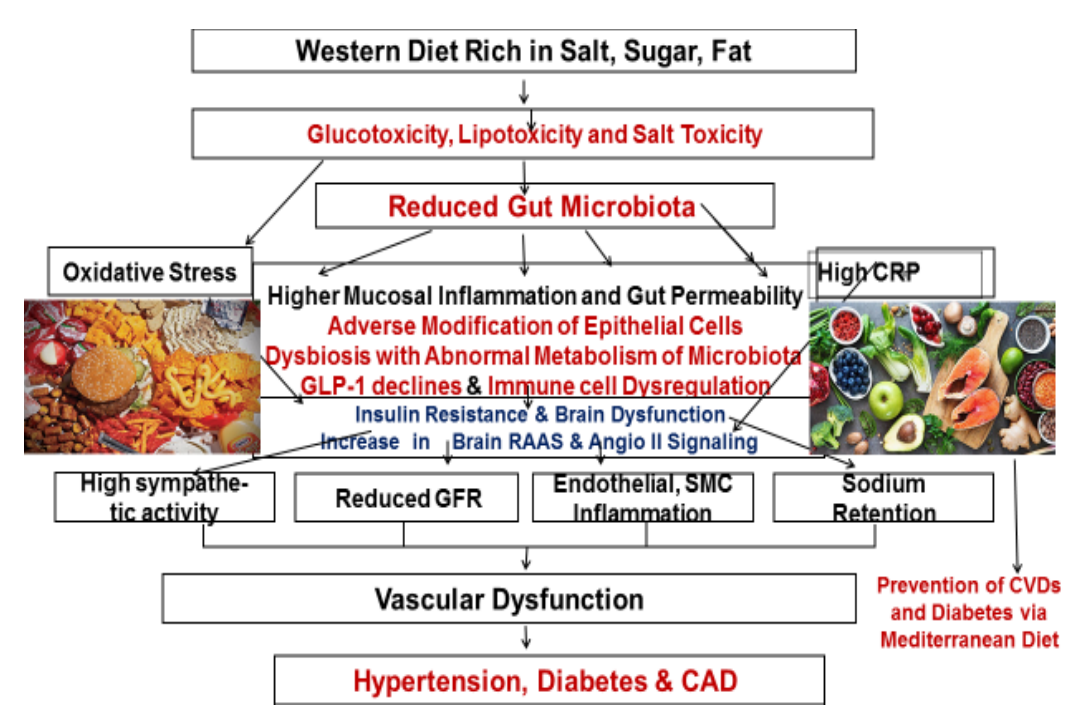
Figure 3. Western diet reduces gut microbiota and dysregulate gut ‐ brain ‐ kidney ‐ axis in the development of hypertension.